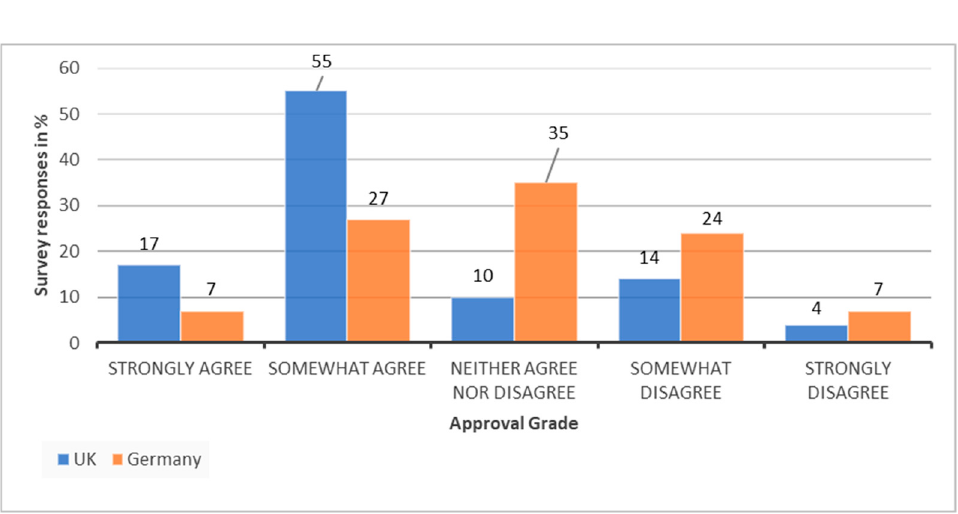
Figure 7. Comparison of the UK and German survey participants on support system for sustaina- Comparison of the UK and German survey participants on support system for bility initiatives. sustainability